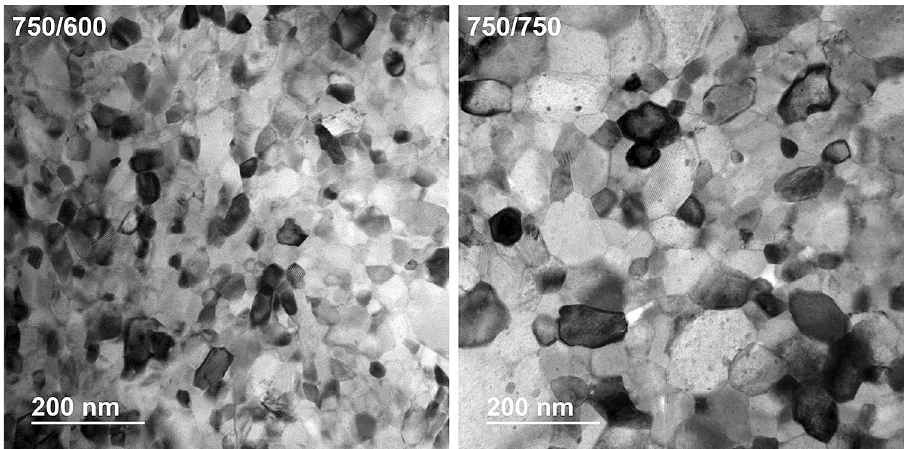
Figure 7. TEM images of K-Ba122 samples. Representative grain structures of two samples heat treated at 750 °C/20 h + 600 °C/10 h and 750 °C/20 h + 750 °C/10 h showing a clear difference in grain